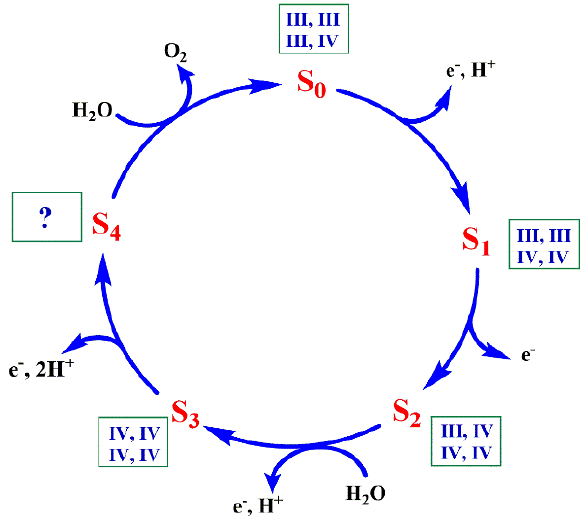
Figure 1. The turnover of the OEC in PSII. The valences of the four manganese ions in different S states are according to the high-oxidation paradigm (see main text for details).